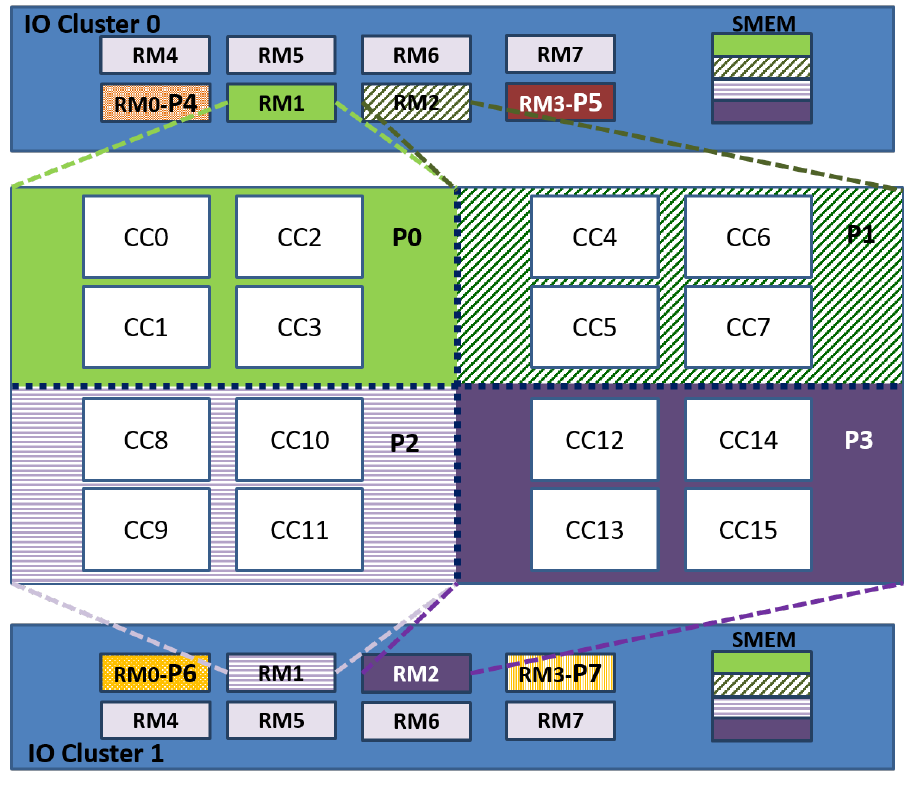
Figure 2. Proposed configuration for the case-study. CCx: Compute Cluster x, being x 0 to 15.